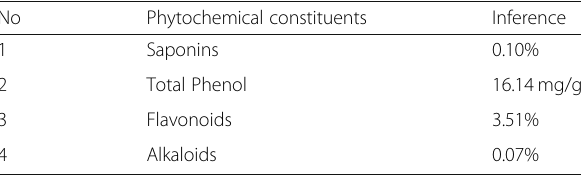
Table 3 Quantitative phytochemical analysis of aqueous extract of fruit pulp of A. digitata L.